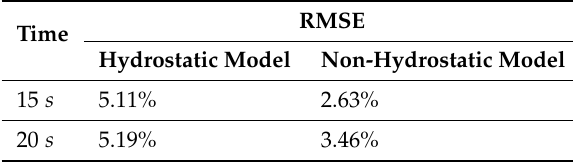
Table 1. Error for breaking solitary wave ( A / d 0 =